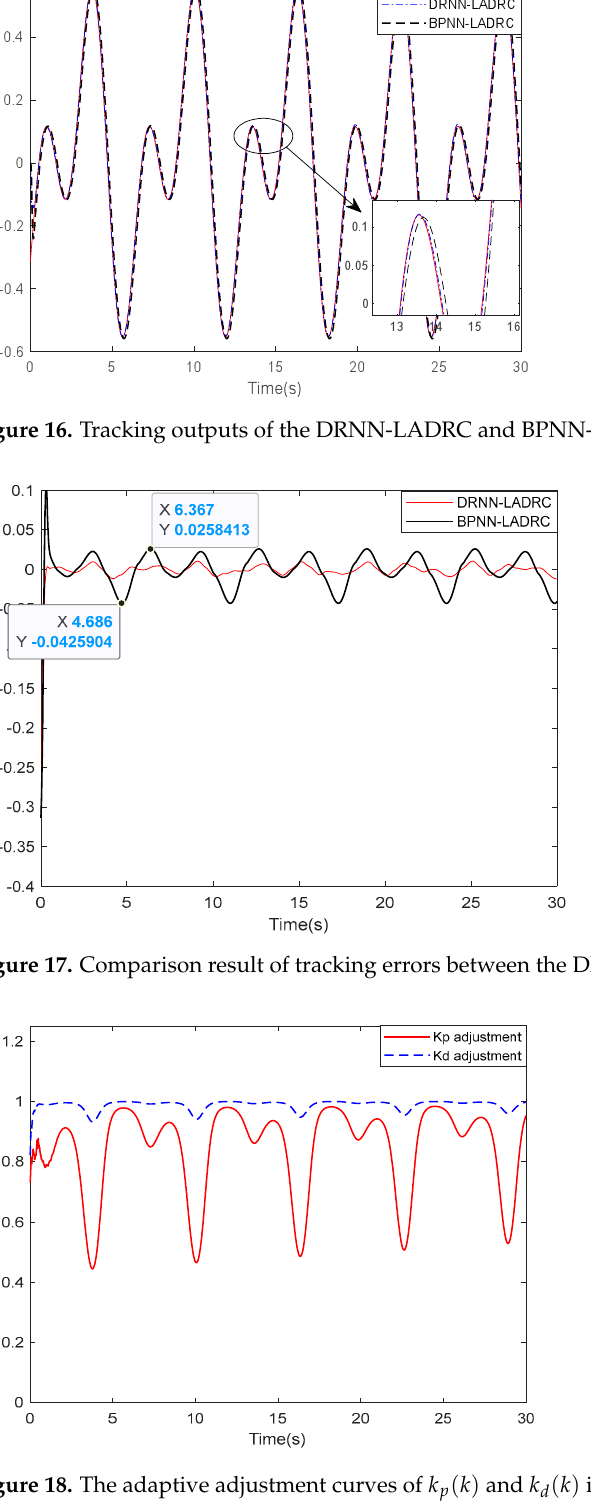
Figure 18. The adaptive adjustment curves of k p ( k ) and k d ( k ) in